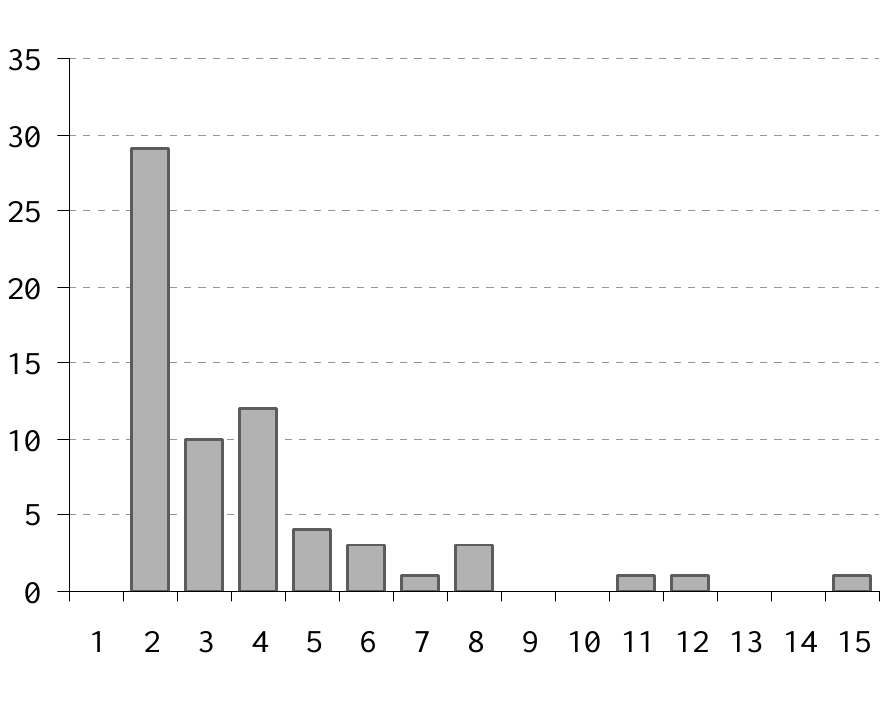
Figure 1: The duration of fiscal consolidations (number of consolidations lasting for x